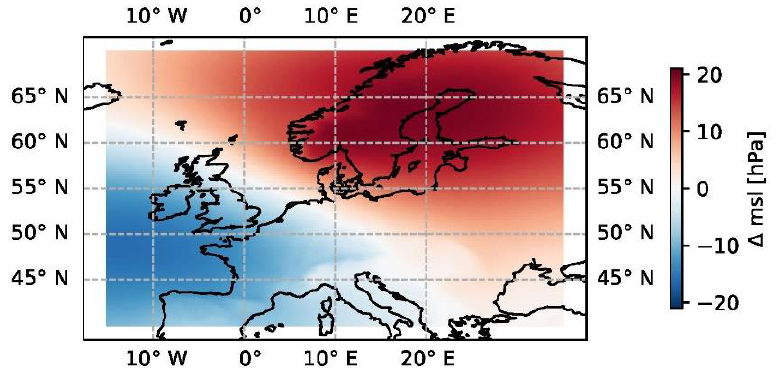
Figure 7. Mean sea level pressure anomaly field during a 24-h period before the respective 271 ELWs derived from 1950–2019 ERA5 reanalysis data, compared to the climatology of 1971 – 2000.